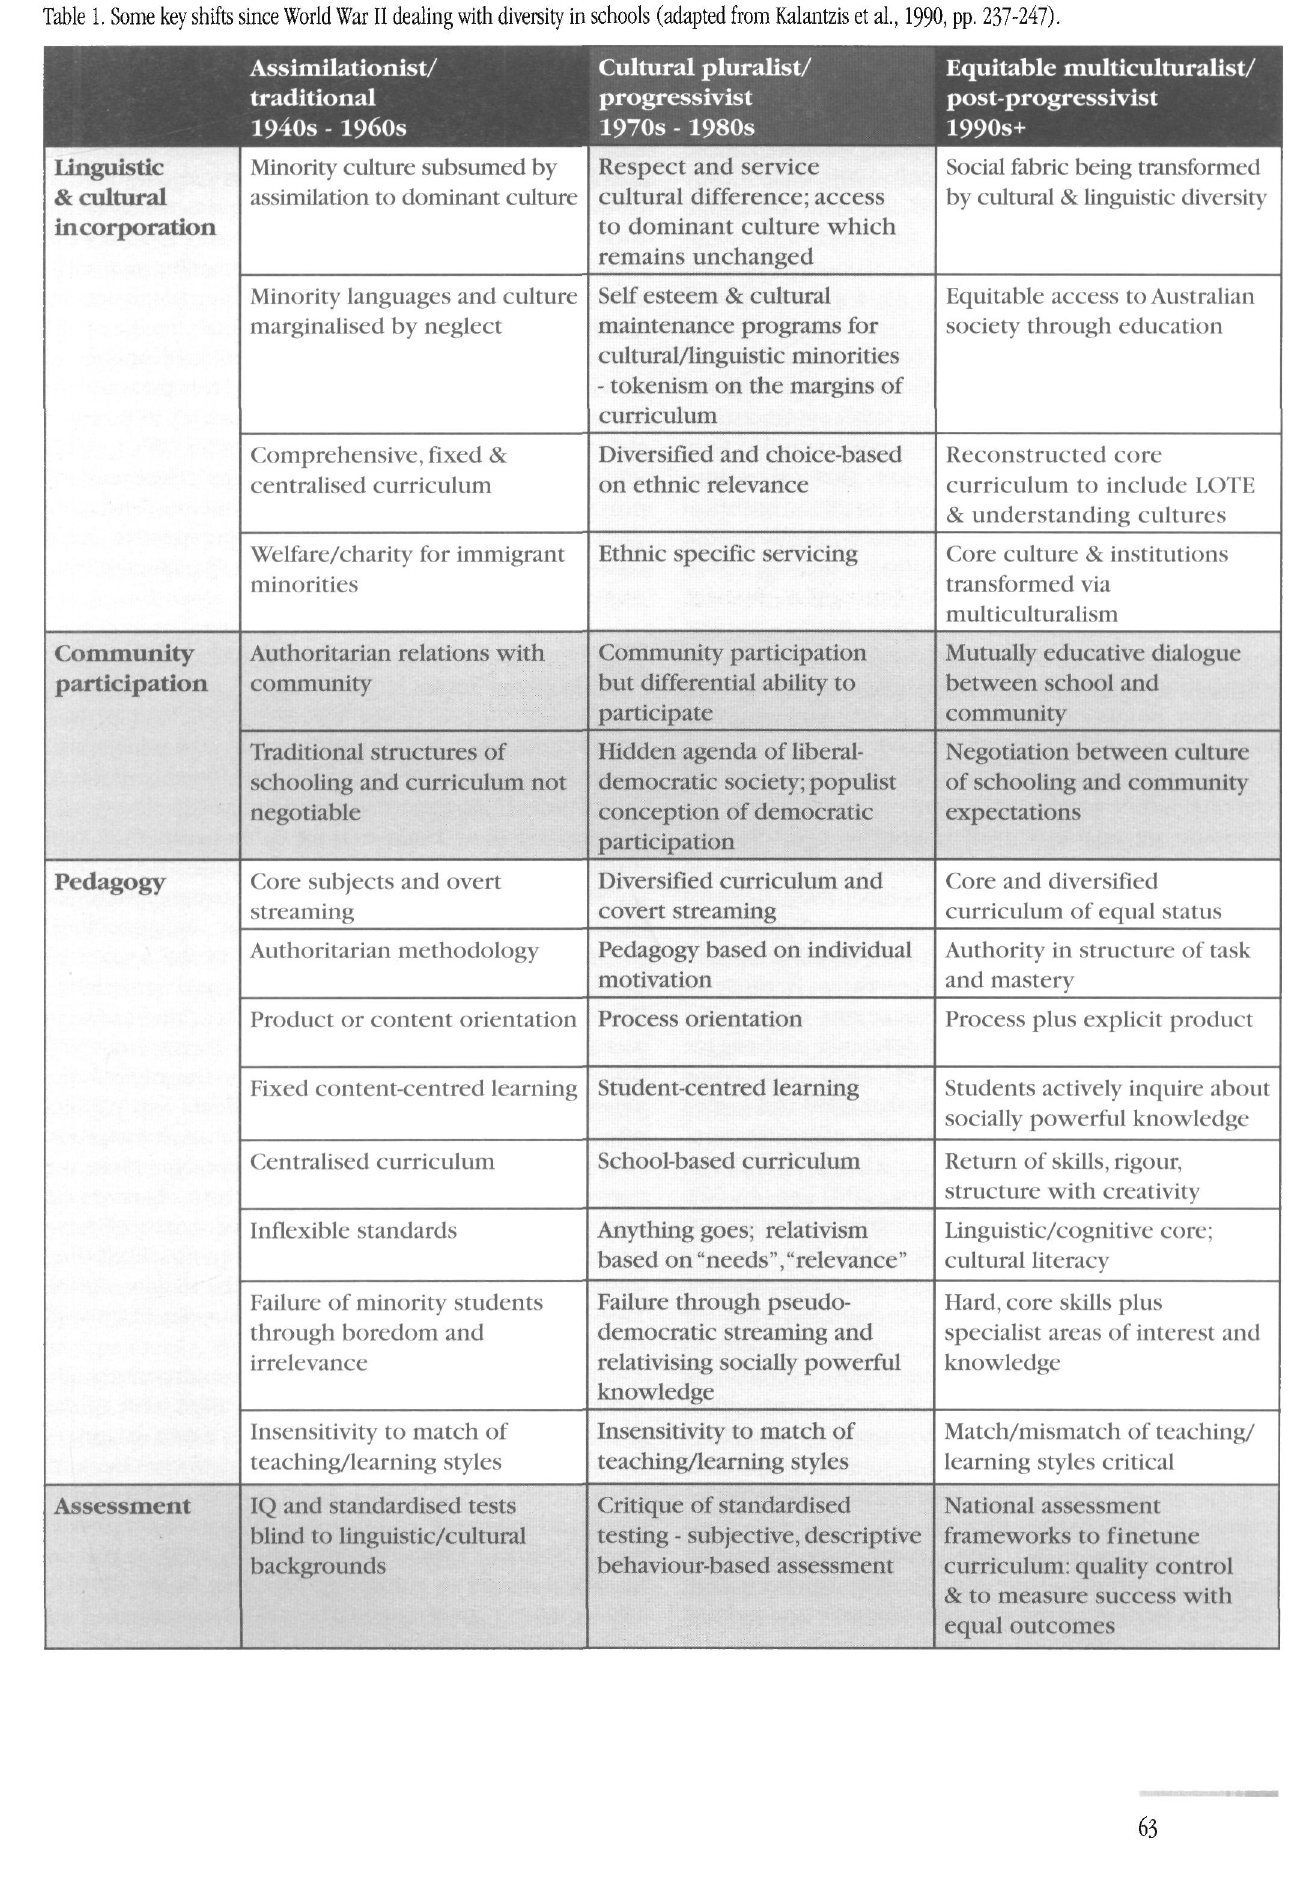
Table 1. Some key shifts since World War II dealing with diversity in schools (adapted from Kalantzis et al., 1990, pp. 237-247). Assimilationist/ traditional 1940s - 1960s